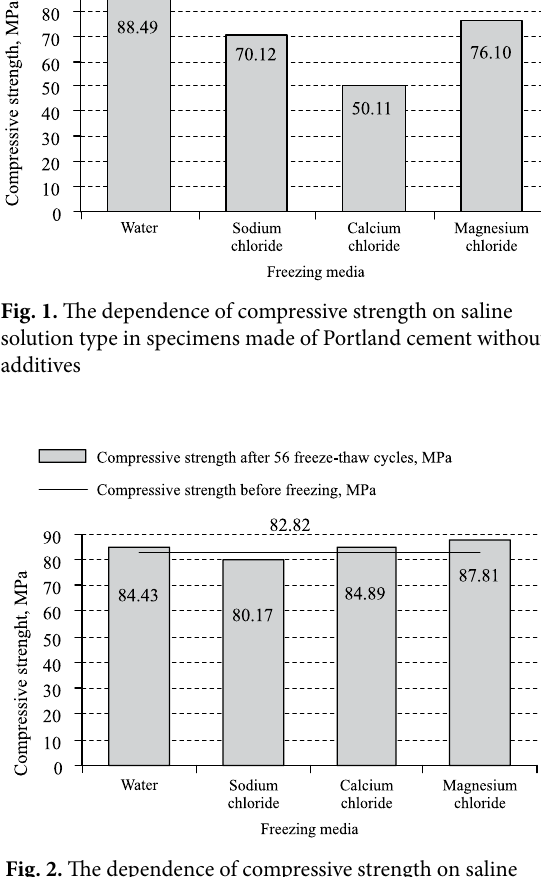
Fig. 2. The dependence of compressive strength on saline solution type in specimens made of Portland cement with NST